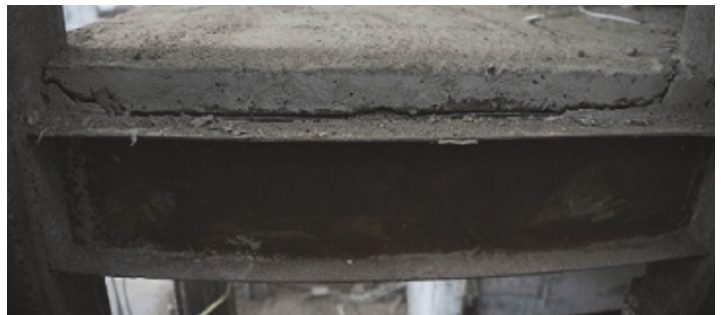
Figure 15: Cracks on slab at the second